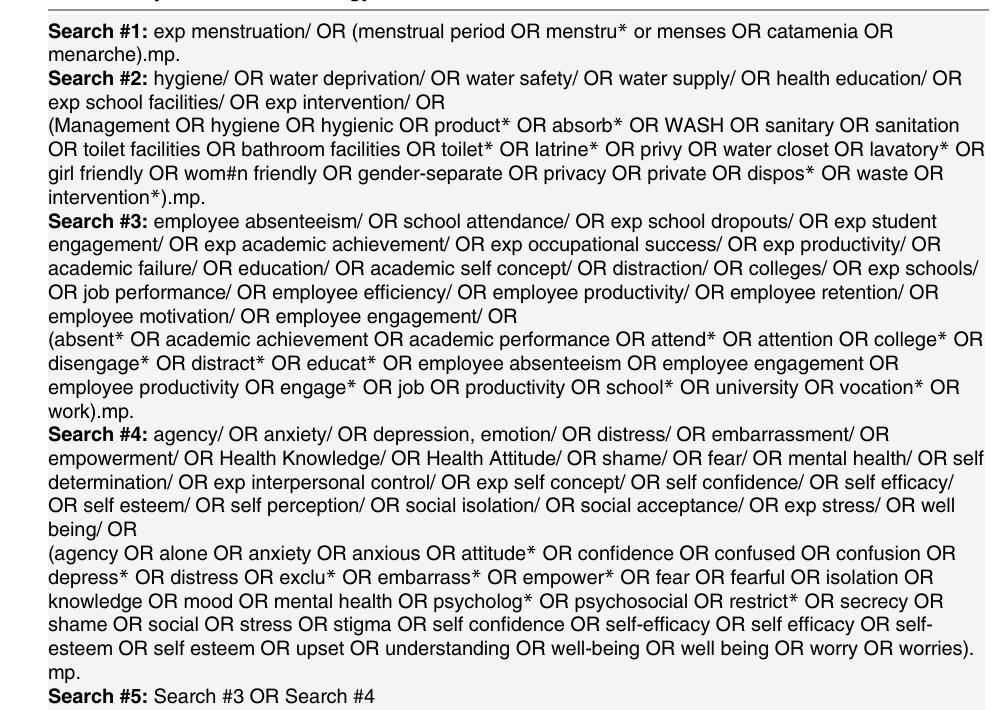
Table 1. PsycINFO search strategy. Search #1: exp menstruation/ OR (menstrual period OR menstru * or menses OR catamenia OR menarche).mp. Search #2: hygiene/ OR water deprivation/ OR water safety/ OR water supply/ OR health education/ OR exp school facilities/ OR exp intervention/ OR (Management OR hygiene OR hygienic OR product * OR absorb * OR WASH OR sanitary OR sanitation OR toilet facilities OR bathroom facilities OR toilet * OR latrine * OR privy OR water closet OR lavatory * OR girl friendly OR wom#n friendly OR gender-separate OR privacy OR private OR dispos * OR waste OR intervention * ).mp. Search #3: employee absenteeism/ OR school attendance/ OR exp school dropouts/ OR exp student engagement/ OR exp academic achievement/ OR exp occupational success/ OR exp productivity/